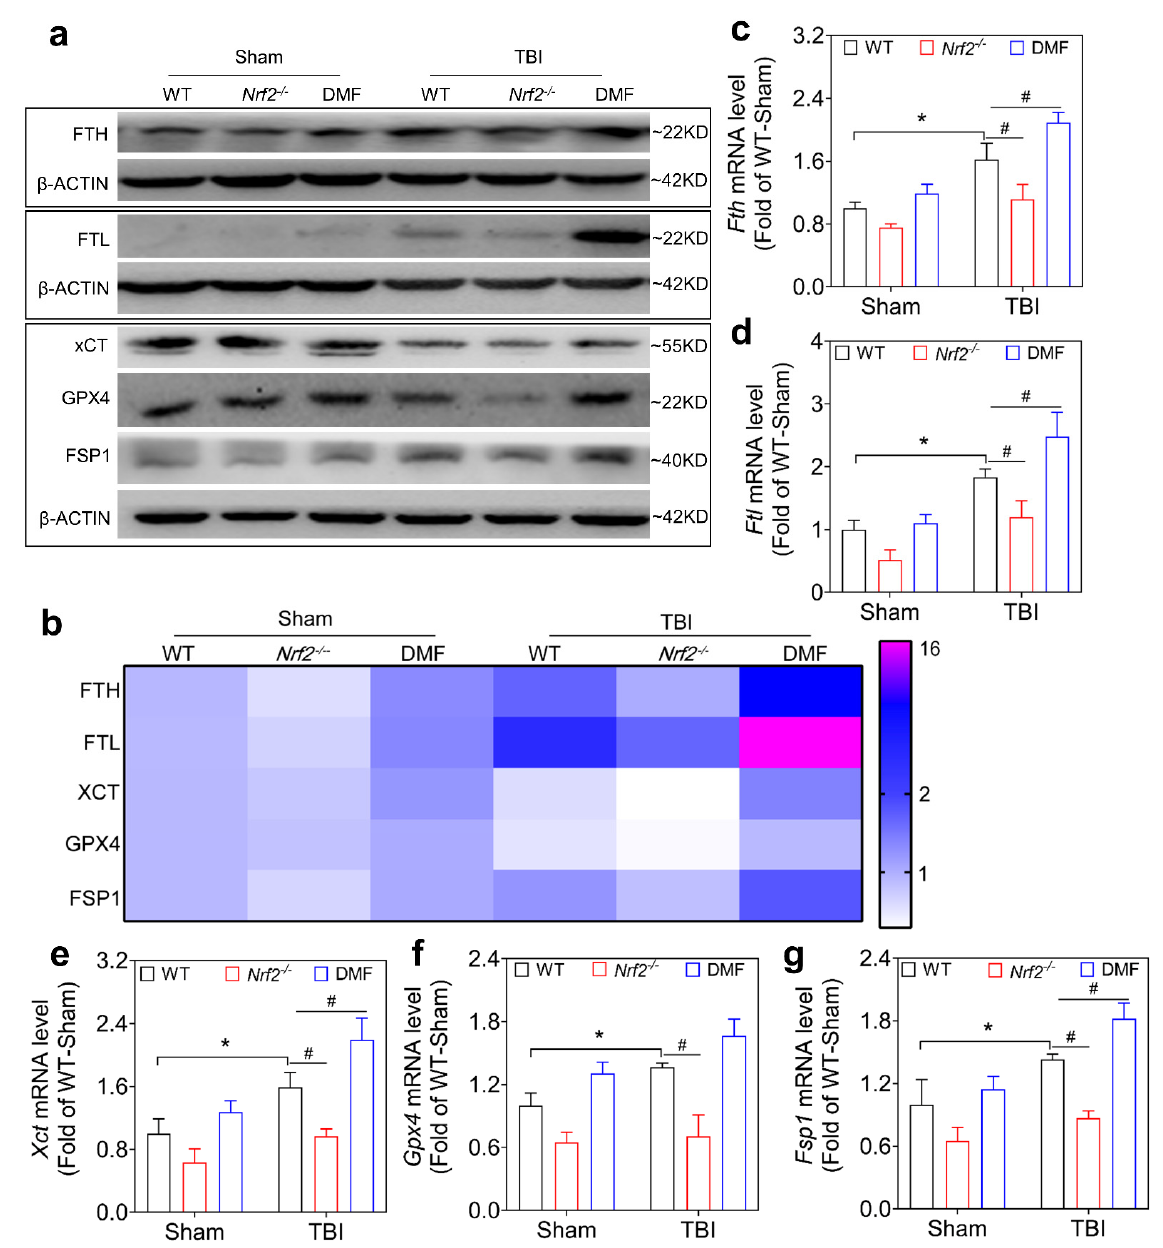
Figure 5. NRF2 regulates the expression of ferroptosis pathway-related FTH, FTL, xCT, GPX4, and FSP1. ( a ) Representative protein levels of FTH, FTL, xCT, GPX4, and FSP1 in the injured cortices of WT, Nrf2 − / − , and DMF-treated mice at 3 dpi. ( b ) Heat map of relative intensity of FTH,